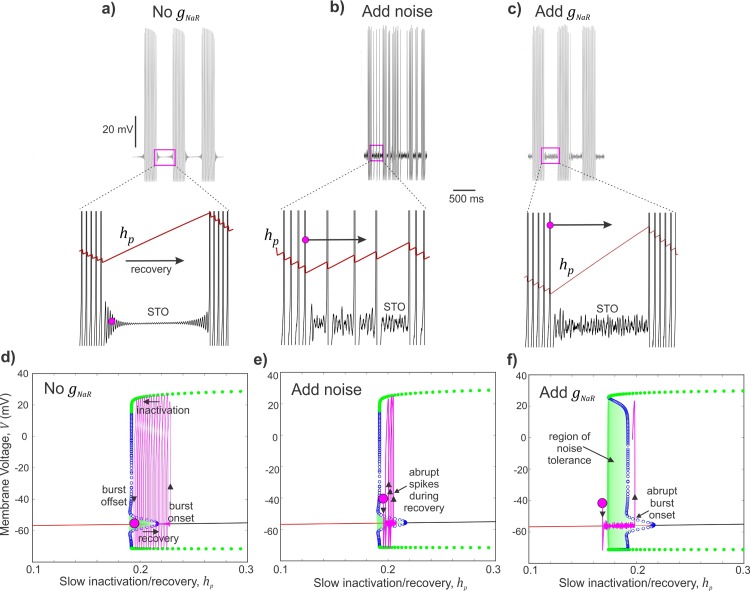
Resurgent Na+ current offers burst stability and noise modulation.a—c) Simulated membrane voltage shows neural activity patterns without any gNaR
(a), with additive Gaussian noise input (b), and with subsequent addition of gNaR
(c). Expanded regions in (a-c) show membrane voltage sub-threshold oscillations (STO) during an inter-burst interval. Also overlaid is the evolution of the slow sodium inactivation/recovery variable; arrow indicates recovery during IBI, and magenta circle marks an arbitrary time point used to track these trajectories in (d—f). d—f) Bifurcation diagrams with projected trajectories of (h∞,V), shown in magenta to highlight the effect of addition of noise near sub-threshold voltages (e) and then the enlarged region of noise tolerance (highlighted green shaded region) due to addition of gNaR in (f). The magenta circle marks the beginning time points of each trajectory.